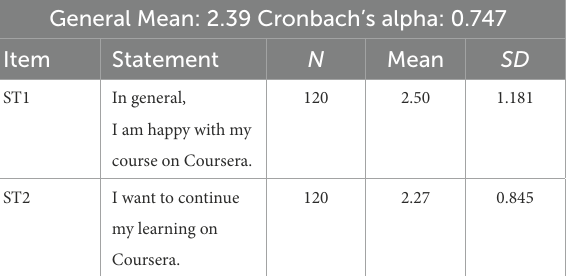
TABLE 4 Statistics for